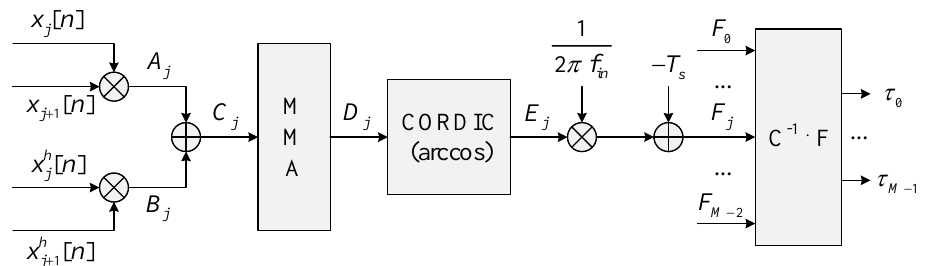
Figure 4. The implementation structure of the proposed timing-mismatch estimation algorithm based on a Hilbert filter, MMAs and inverse cosine